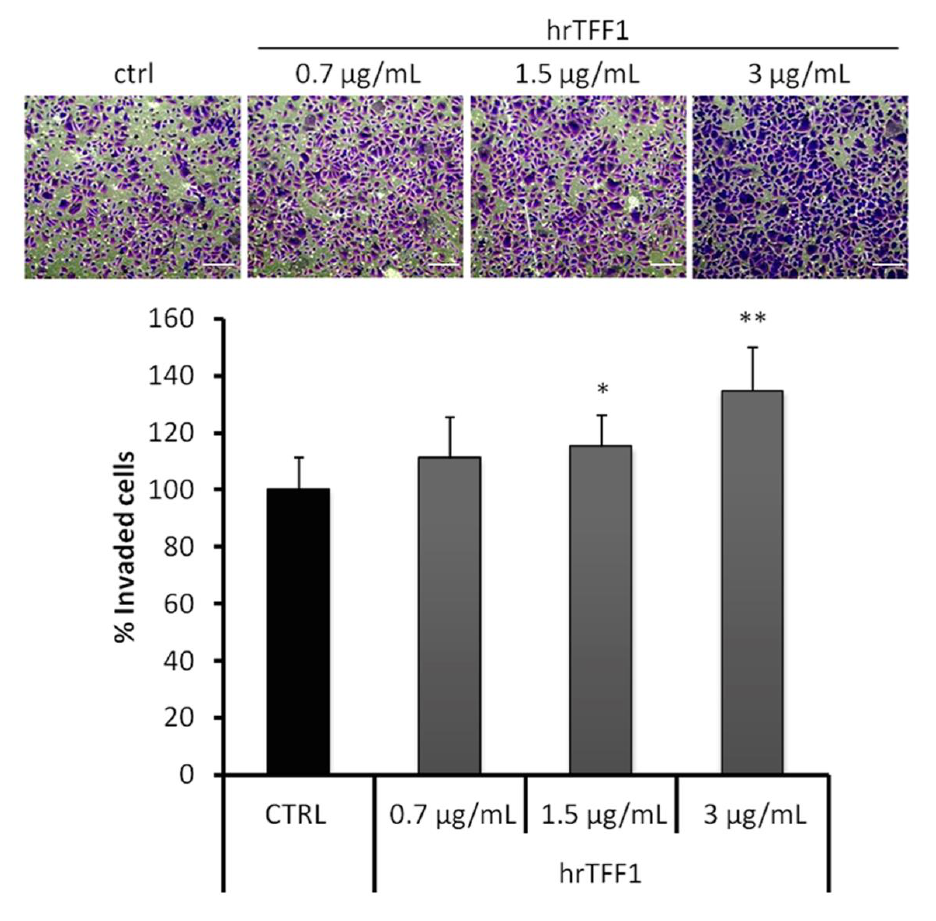
Figure 2. Recombinant TFF1 stimulates the invasive activity of AGS cells. Invasiveness rate of AGS treated or not with human recombinant dimeric TFF1 protein (hrTFF1) protein. Upper panel, bottom surface of filters stained with crystal violet. Magnification 10×. Bar = 100 μm. Lower panel, quantification of invasive cells. * p < 0.01 and ** p < 0.001 vs. untreated control.